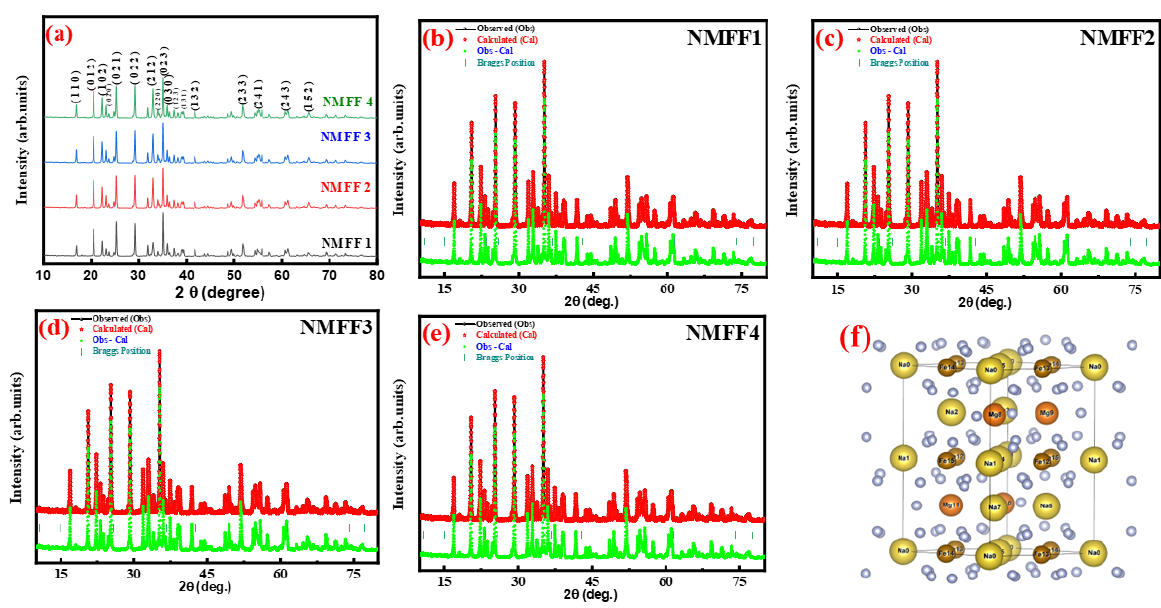
Figure 2. ( a ) XRD and refinement results of ( b ) NMFF1, ( c ) NMFF2, ( d ) NMFF3, and ( f ) NMFF4 ( e ) crystal structure of O 3 -type NaFe1-xMgxO 2.